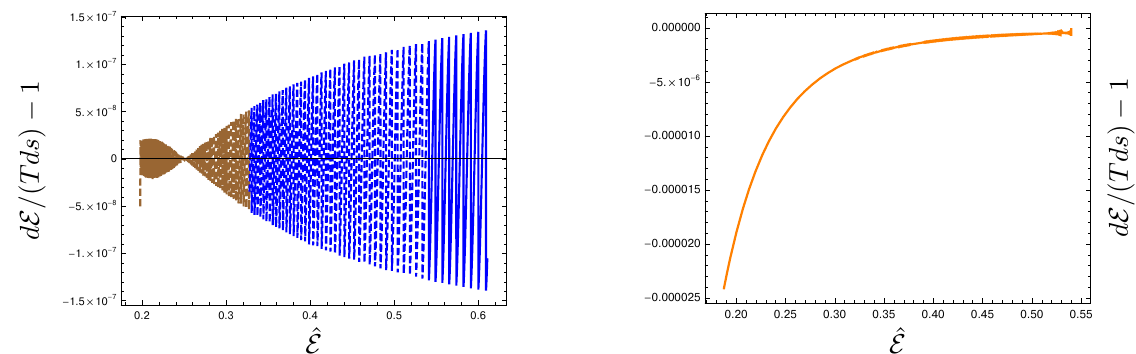
Figure 35 . The first law of thermodynamics for the Klebanov-Tseytlin (the left panel) and the Klebanov-Strassler (the right panel) black holes at µ = µ 1 , see (6.18). The color coding as in figure